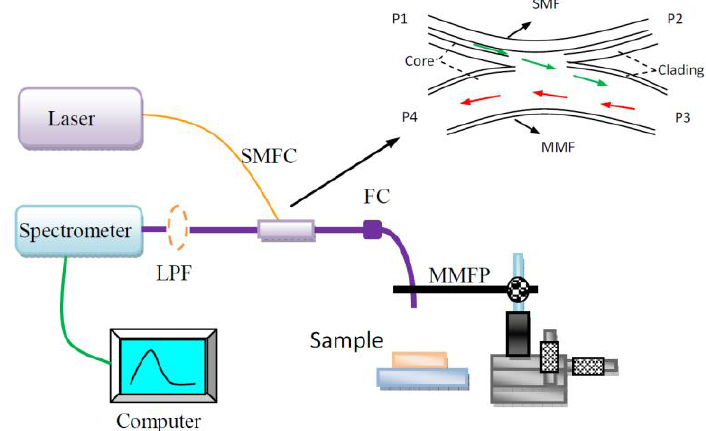
Figure 1. Schematic of the photofluorescence sensing platform based on the proposed optical probe: SMFC, single-multi-mode fiber coupler; FC, fiber connection; LPF, long pass filter; MMF, multi-mode fiber; SMF, single-mode fiber; Inset: schematic of the SMFC coupler. The laser light coming along the core of the P1 port is mostly delivered into the core of the P3 port; the fluorescence collected by the P3 port was directly coupled to the P4